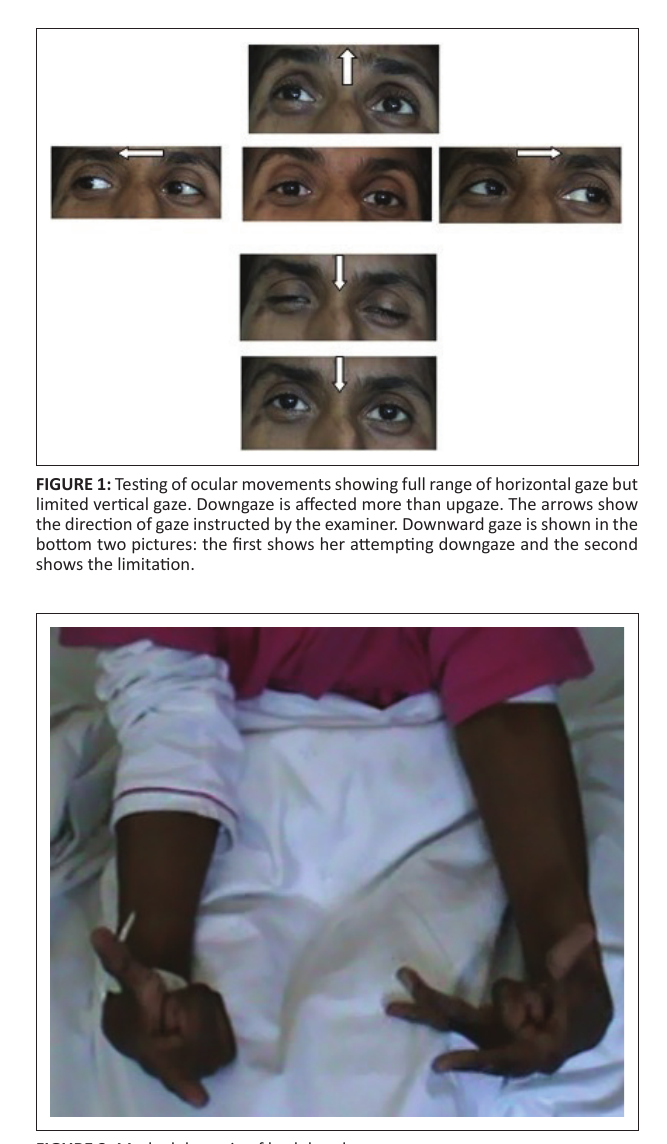
FIGURE 2: Marked dystonia of both